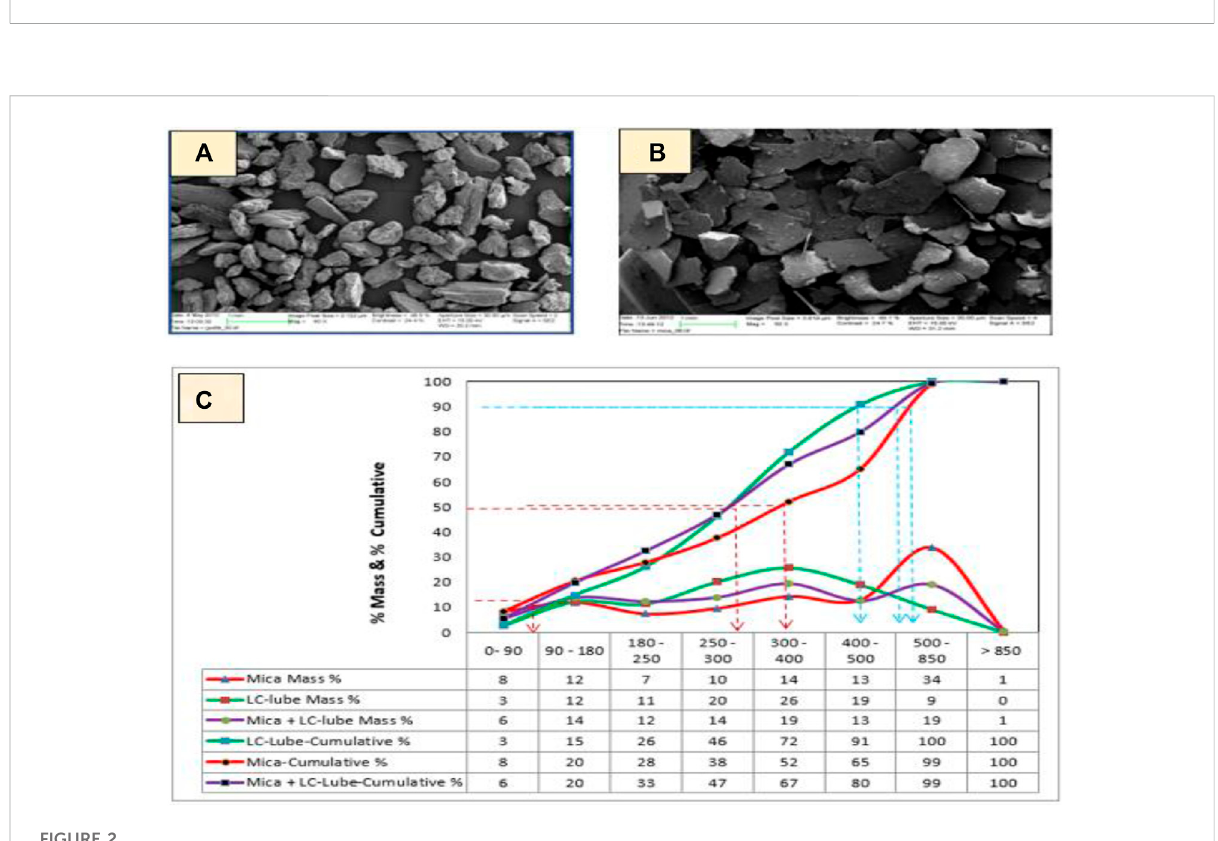
FIGURE 2 SEM picture of LC-LUBE (A) and mica (B) , and cumulative particle size distribution (size is in micrometer) (C)